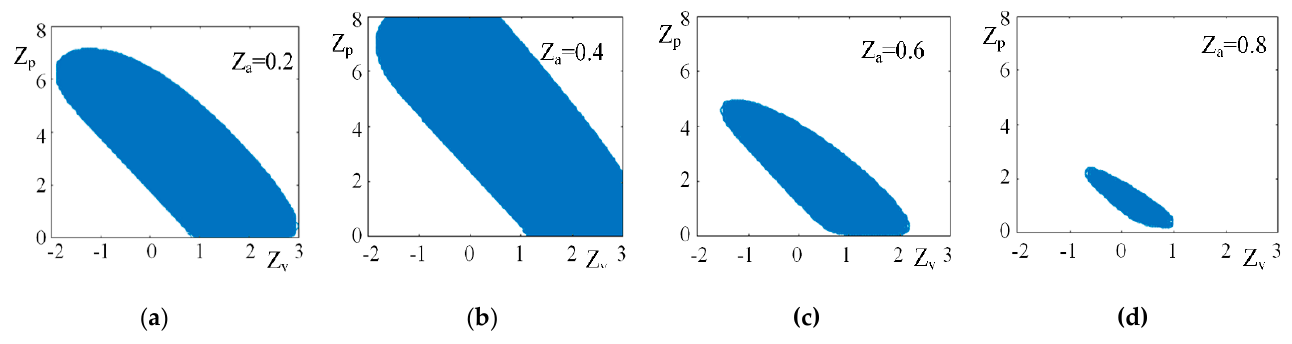
Figure 4. Stability region diagram under the influence of parameters Z a . ( a ) Z a = 0.2; ( b ) Z a = 0.4; ( c ) Z a = 0.6; ( d ) Z a =